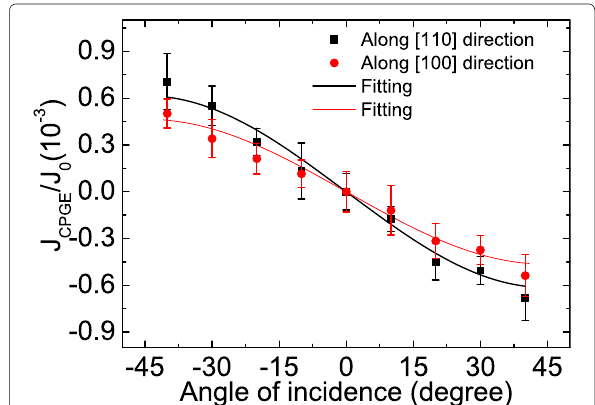
Fig. 6 Incident angle dependence of the normalized CPGE current collected along different crystal orientations. The CPGE current is normalized by the photocurrent under a bias of 0.3 V. The solid symbols are the experimental data, and the lines are the fitting results according to Eq.